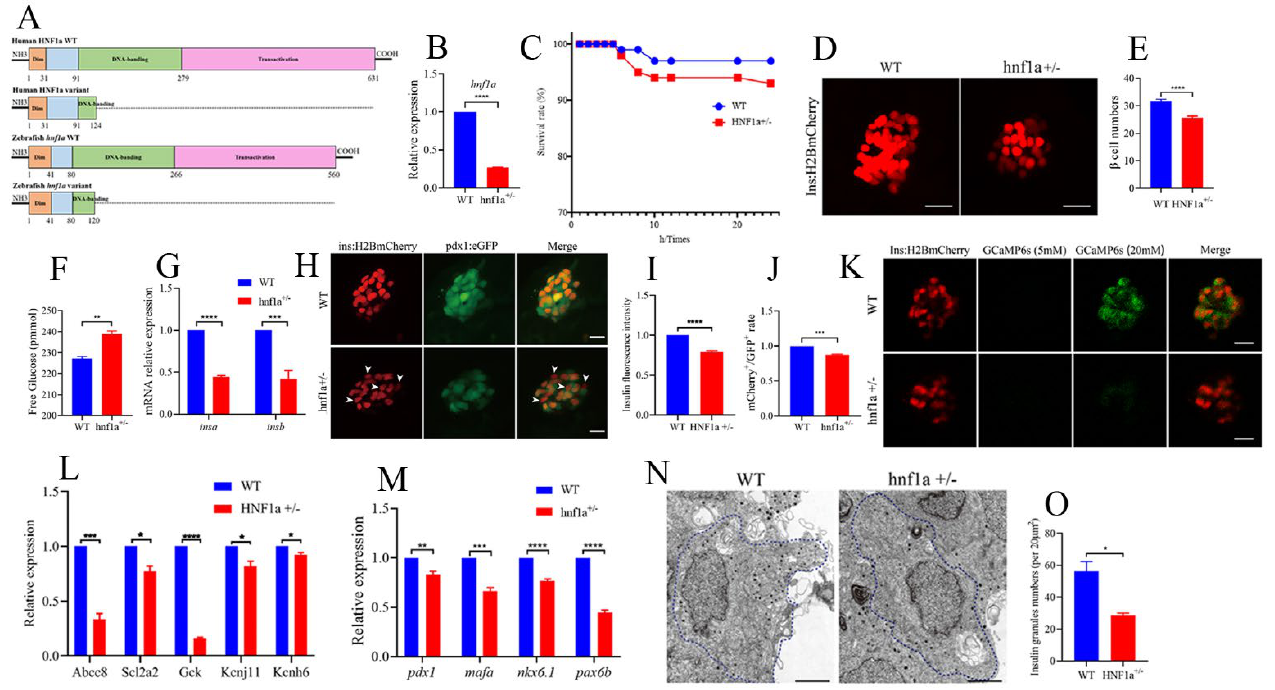
Figure 2. Similar variant impaired β -cell function in zebrafish. ( A ) Schematic representation of a similar HNF1a-Q125ter variant in zebrafish generated by CRISPR/Cas9. Mutation was caused via a two-base-pair deletion at the CRISPR target site for HNF1a. ( B ) The transcription level of hnf1a in WT and hnf1a +/ − ; n = 50 larvae for each genotype. ( C ) Survival curves of WT and hnf1a +/ − zebrafish from 0 h to 24 h. ( D , E ) Representative confocal images ( D ) and quantification ( E ) of the β -cell number from Tg( − 1.2ins:H2BmCherry) and hnf1a +/ − ; Tg( − 1.2ins:H2BmCherry) zebrafish larvae. Scale bar indicates 25 µ m; n = 20–35 larvae for each genotype. ( F ) Total free glucose level of WT and hnf1a +/ − larvae at 6 dpf. ( G ) qRT-PCR analysis of the expression of insa and insb mRNA levels in WT and hnf1a +/ − larvae at 6 dpf. ( H ) Representative confocal images of Tg(ins:H2BmCherry); Tg(pdx1:GFP) at 6 dpf for WT and hnf1a +/ − . β -cells expressed insulin (mCherry + ) without pdx1 (GFP − ) are shown by white arrows. Scale bar: 10 µ m. ( I ) Quantification of fluorescence intensity for insulin in WT and hnf1a +/ − . ( J ) Quantification of double-positive cells’ (mCherry + /GFP + ) rate in WT and hnf1a +/ − larvae at 6 dpf; n = 3 larvae for each genotype. ( K ) Representative images of GCaMP6s response in β cells of Tg(Ins:H2BmCherry); Tg(Ins:GCaMP6s) and hnf1a − / − ; Tg(Ins:H2BmCherry); Tg(Ins:GCaMP6s) by 5 or 20 mM glucose ECS solution; the green signal is GCaMP6s. Scale bar: 10 µ m. ( L ) RT-qPCR quantification of mRNA levels for insulin-secretion markers in WT and hnf1a +/ − larvae at 6 dpf: abcc8, scl2a2, gck, kcnj11, and kcnh6. ( M ) RT-qPCR quantification of mRNA levels for β -cell maturation and differentiation markers in WT and hnf1a +/ − larvae at 6 dpf: mafa, pdx1, nkx6.1, and pax6b. ( N , O ) Representative electron micrographs of β cells ( N ) and quantification of insulin granules ( O ) in β cells from WT and hnf1a +/ − larvae at 6 dpf. ( N , O ) Transmission electron microscopy for insulin granules. Islet isolation from WT and hnf1a +/ − larvae at 6 dpf. The dotted blue lines represent intact individual β cells. Bar scale: 2 µ m. n = 3 intact individual β cells for each genotype. Results are represented as means with standard errors; * p < 0.05, ** p < 0.01, *** p < 0.001, and **** p < 0.0001. Student’s t -test. All experiments were performed at least three times, unless otherwise indicated. WT, wild